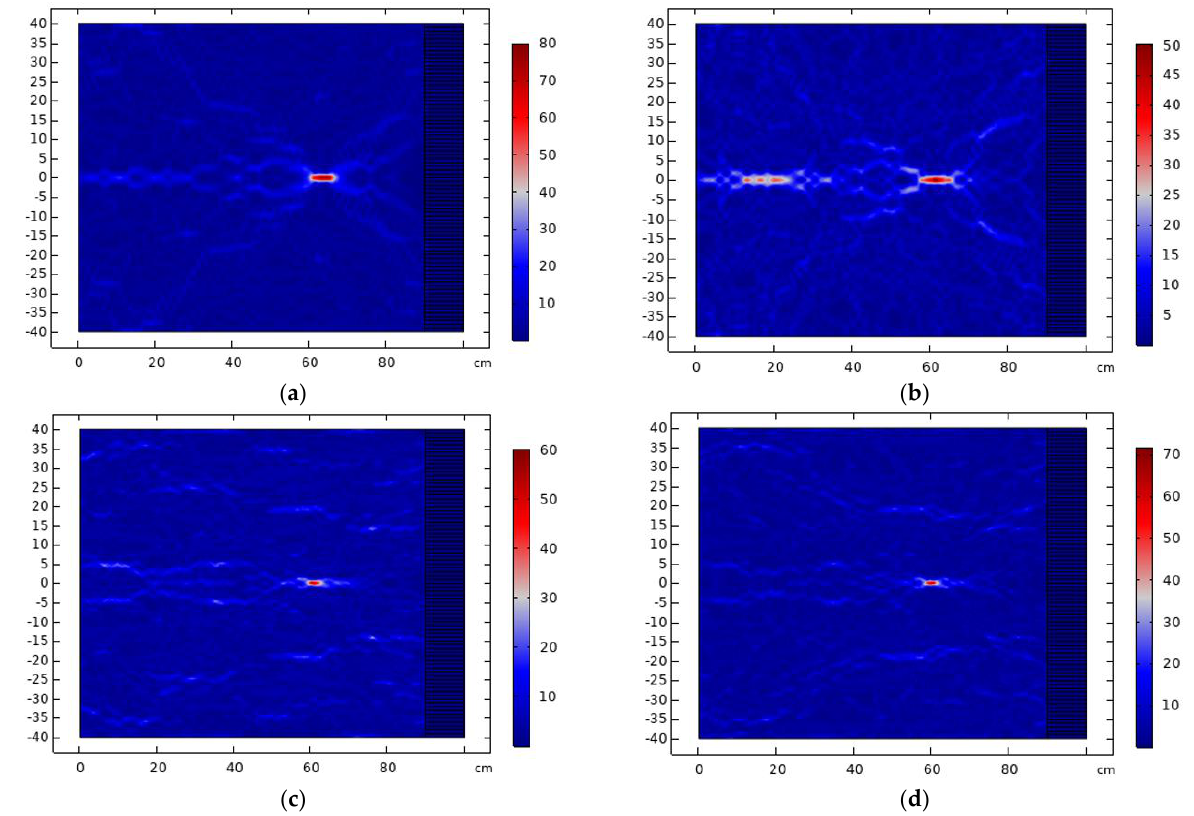
Figure 16. Spatial distributions of acoustic intensity field through focusing lens at ( a ) 28 kHz, ( b ) 35 kHz, ( c ) 40 kHz, and ( d ) 45 kHz.